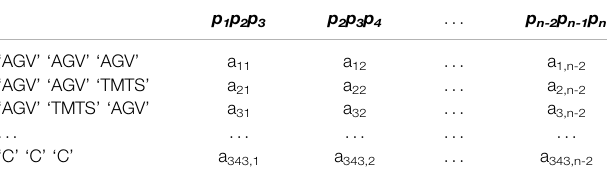
TABLE 2 | 3-mer sparse matrix of protein